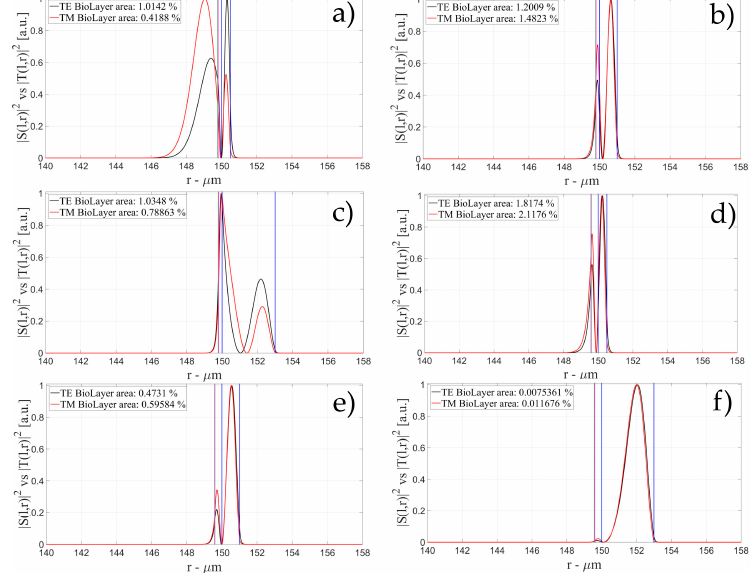
Figure 11. Electric field distribution of WGMs along the radial direction for TE (| S ( l,r ) | 2 ) and TM (| T ( l,r ) | 2 ) modes for the 2nd radial order: ( a ) for a wall of about 500 nm and a polymer thickness of about 200 nm; ( b ) for a wall of about 1 μ m and a polymer thickness of about 200 nm and ( c ) for a wall of about 3 μ m and a polymer thickness of about 200 nm; ( d ) for a wall of about 500 nm and a polymer thickness of about 400 nm; ( e ) for a wall of about 1 μ m and a polymer thickness of about 400 nm and ( f ) for a wall of about 3 μ m and a polymer thickness of about 400 nm Legends show the fraction of | S ( l,r ) | 2 and | T ( l,r ) | 2 inside the biological layer.